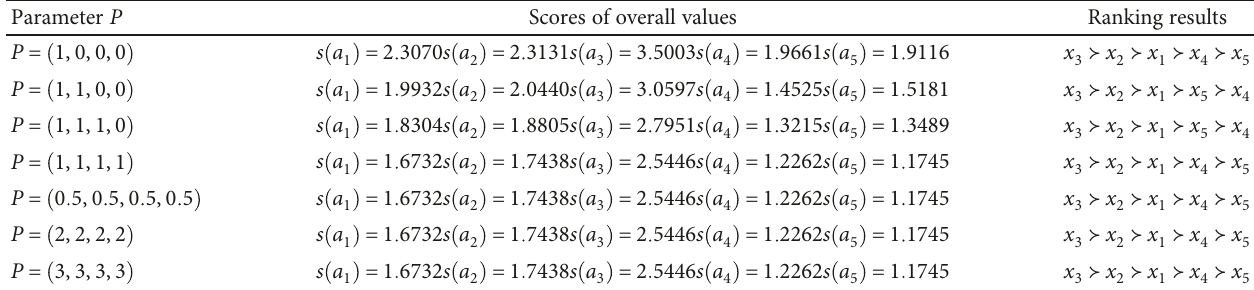
Table 5: Ranking results by assigning di ff erent values to parameter vector P in the HFLWMM operator. Parameter P Scores of overall values Ranking